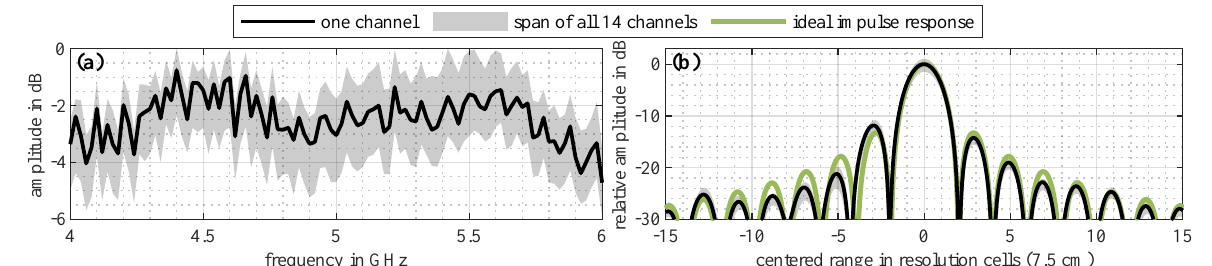
Figure 3. Graphs of measured calibration data first published in our article [9], with ( a ) frequency responses and ( b ) corresponding spatial-domain transformations. The range axis in ( b ) is centered at the maximum of ( — ) and scaled to a range resolution of 7.5cm (corresponding to 2GHz bandwidth and a rectangular band-limited signal). ( — ) Channel response closest to the mean of all curves,